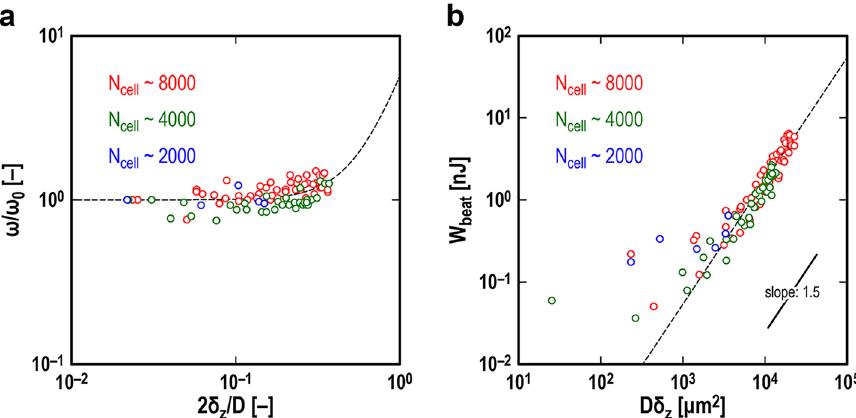
Figure 3. The dynamic properties of single cardiac spheroids (CSs). ( a ) The normalized beating frequency, ω / ω 0 , is plotted against the normalized indentation depth (i.e., effective compression strain) 2 δ z / D , where ω and ω 0 are the beating frequencies under compression and no compression, respectively. The black broken line is a fitting function of ω / ω 0 = 1 + a (2 δ z / D ) n , where the fitting parameters were determined to be a = 4.7 and n = 2.8 by least square analysis. ( b ) The mechanical work performed by a single CS in a single contraction, termed beating energy W beat , is plotted against Dδ z . The black broken line is a fitting function of W beat = b ( Dδ z ) 1.5 , where the fitting parameter was determined to be b = 1.7 × 10 –6 nJ/μm 3 by least square analysis. The plotted data in ( a ) and ( b ) are from 94 contractions of six different CSs, the diameters of which are ranged from 219 to 355